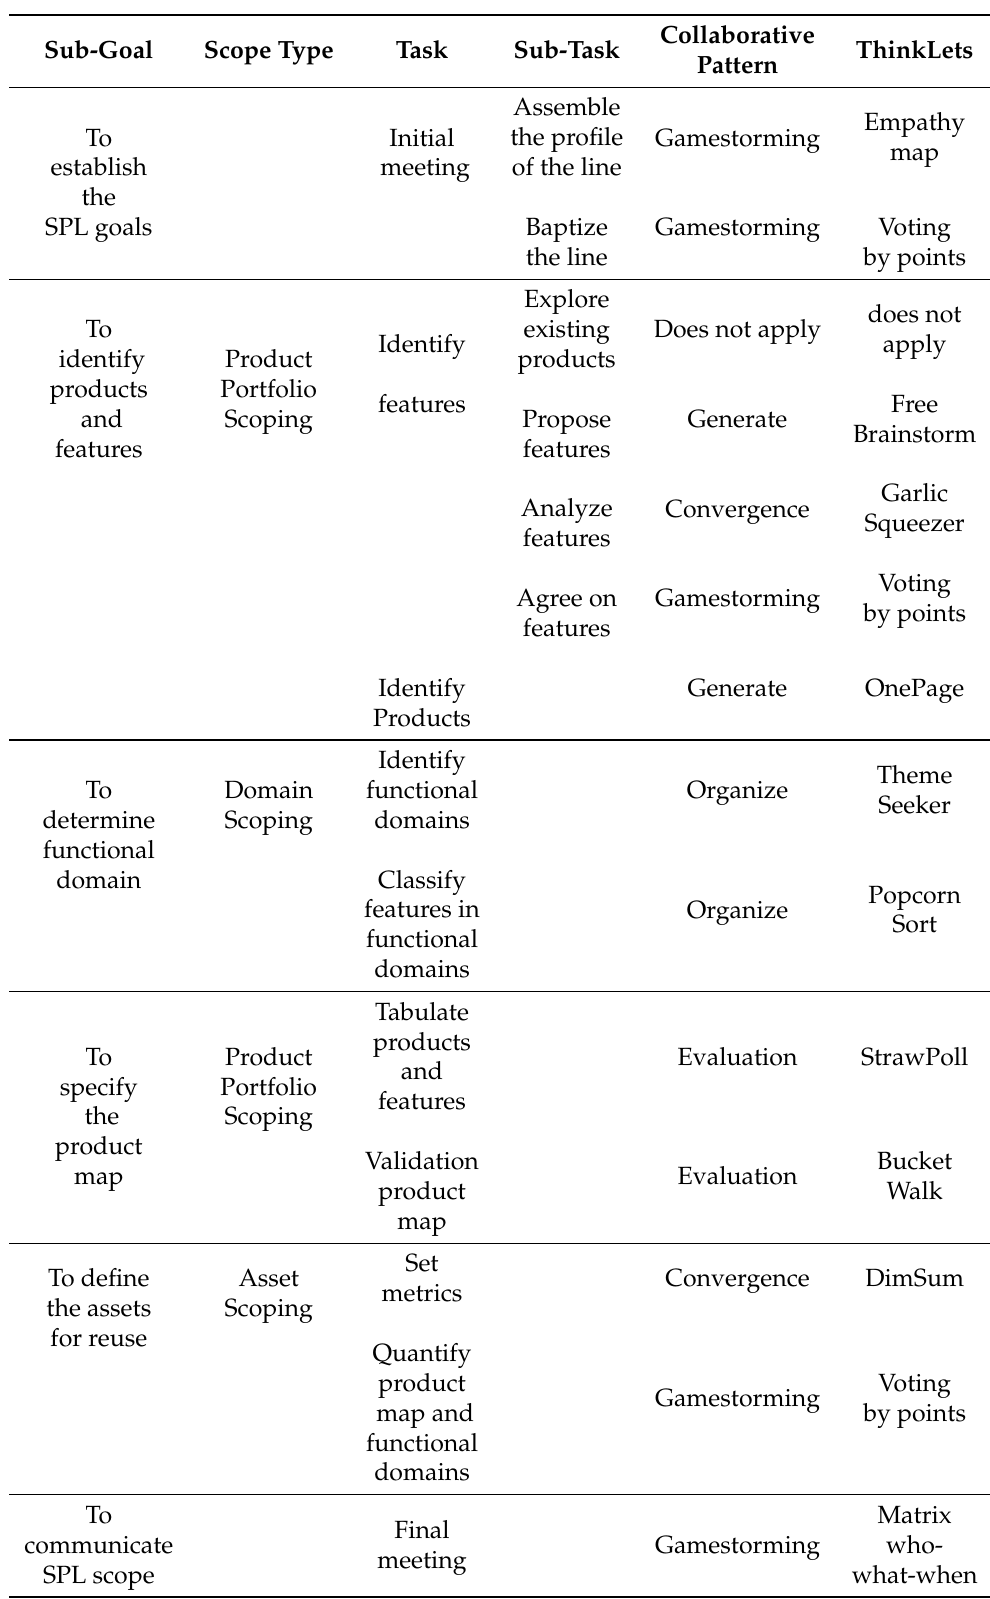
Table 2. CoMeS-SPL (Collaborative Method for Scoping an SPL)